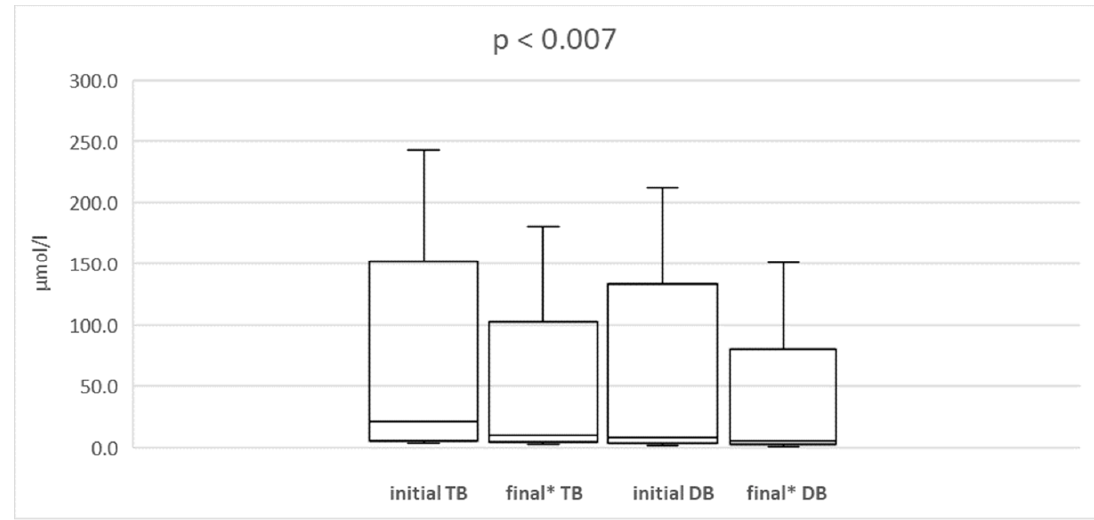
Figure 1. The comparison of initial and final (* at the end of combination therapy) total (TB) and conjugated bilirubin (CB) concentration in the whole group of patients. The lower and upper borders of the box indicate 25th and 75th percentiles, respectively. The line within the box depicts the median. The error bars indicate minimum and maximum.